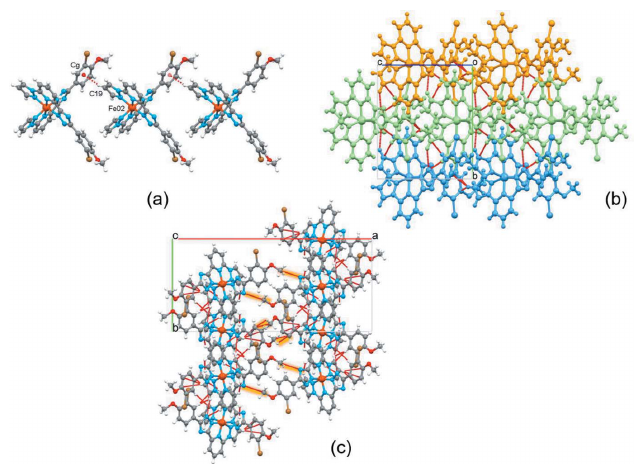
Figure 2 ( a ) Mono-periodic supramolecular chain formed by stacking of molecules of the title compound. ( b ) Di-periodic layers formed by supramolecular chains. For a better representation, each chain has a different colour. ( c ) Highlighted interactions of neighbouring layers in the three-dimensional supramolecular network of the title complex. The red dashed lines correspond to contacts below the sum of the van der Waals radii. The methanol molecules are not shown for